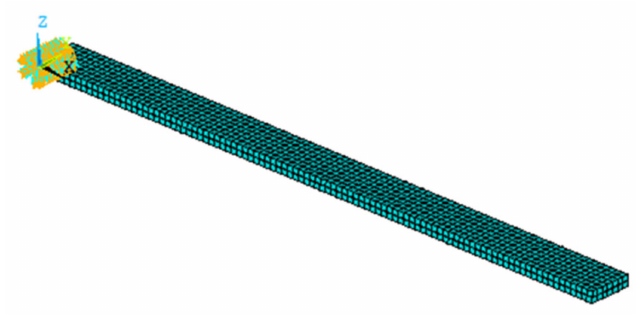
Figure 7. Finite element model of the viscoelastic sandwich beam.